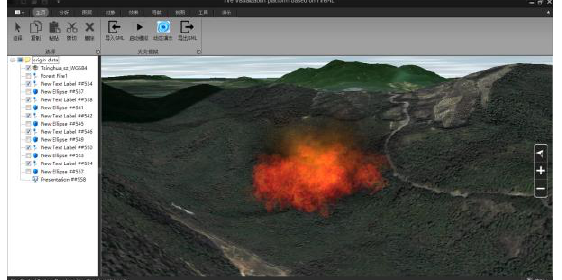
Figure 2. The simulation process with the defined FireML in the